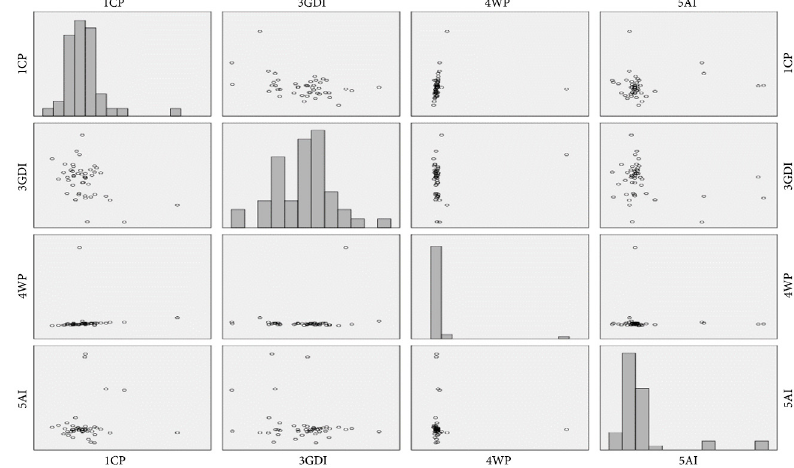
Figure 6. The correlation diagram on the regression and dependent variable for the 2 nd model (source: GRETL